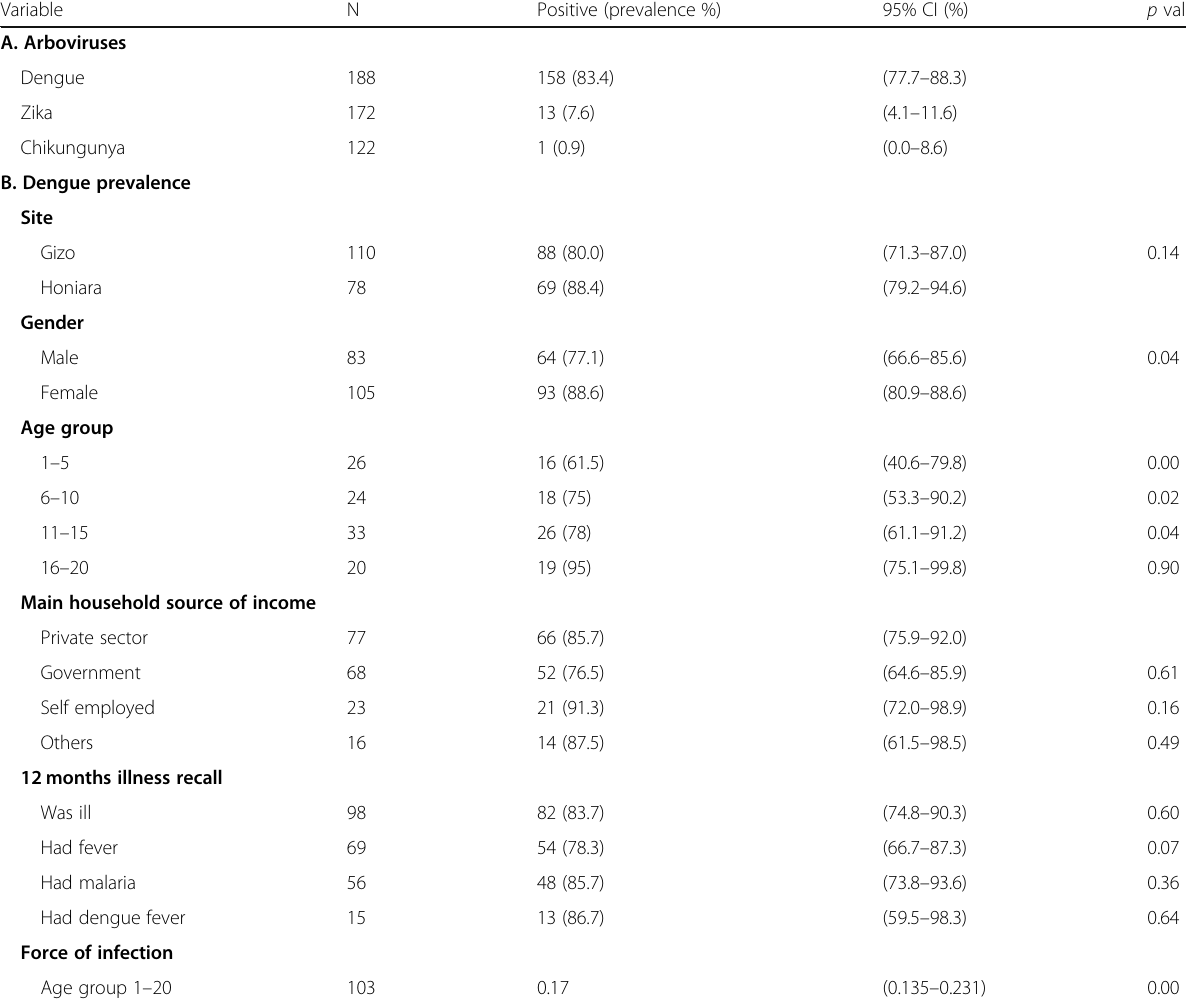
Table 2 The results of the household study in April 2016 showing the various arbovirus prevalence and characterization of the dengue infection in our study population